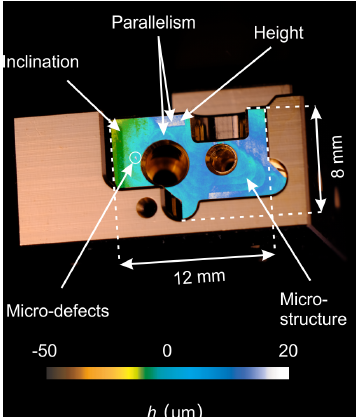
Figure 9. HoloPort maps the component surface in a fraction of a second with micrometer accuracy directly in the machine tool (as in the example of a heat sink for laser assembly). Alongside the ge- ometry, relevant surface parameters such as micro-defects and mi- crostructures as well as the height, parallelism and inclination of surfaces can be measured